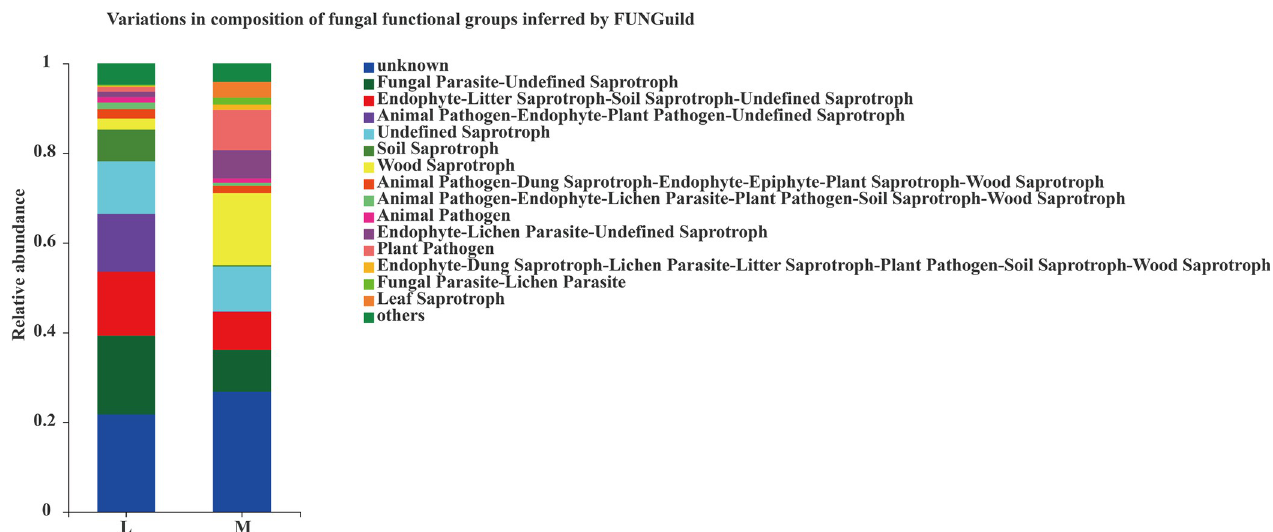
Fig 16. Relative abundance of soil fungal functional groups (guilds) based on OTU annotation table with distribution frequency level between moss- (M) and non-moss growth (L) areas in litchi orchard.